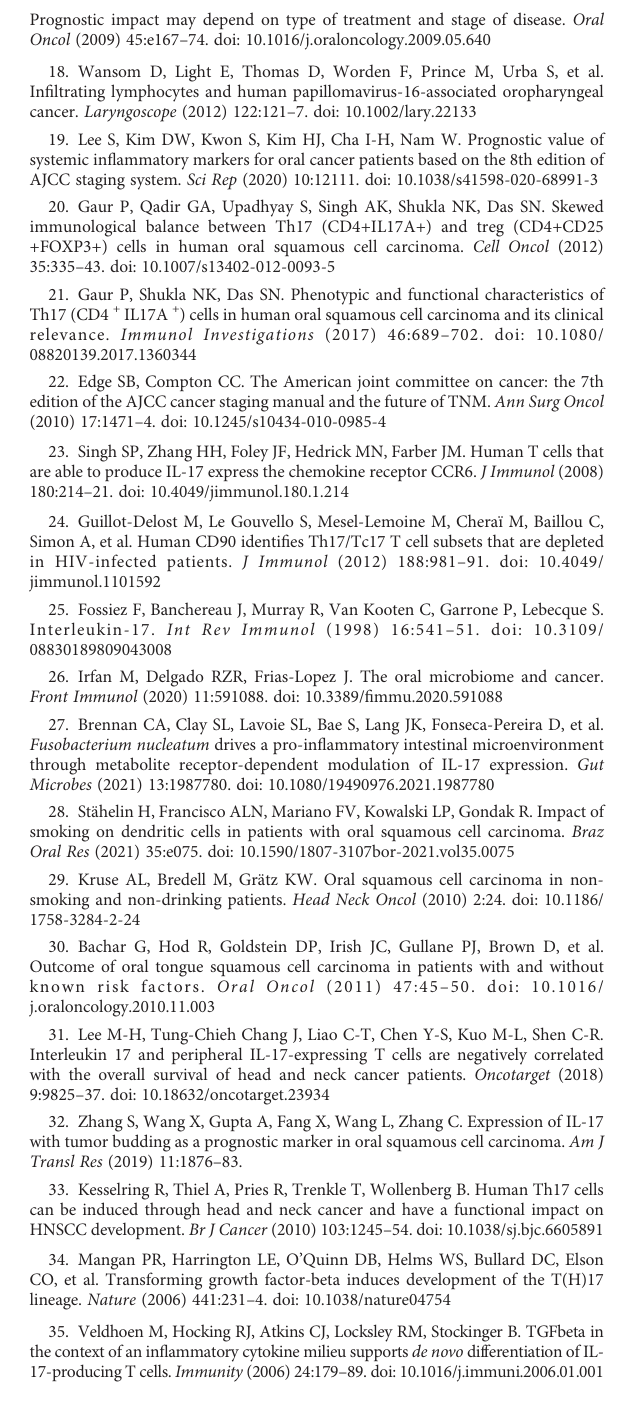
SUPPLEMENTARY FIGURE 1 Gating strategy used in the study of tumor samples and whole blood. After dead cells (for tumor samples) and doublets exclusion, seven subpopulations gated on CD45 + cells were identi fi ed: CD15 + CD11b + (granulocytes), CD14 +